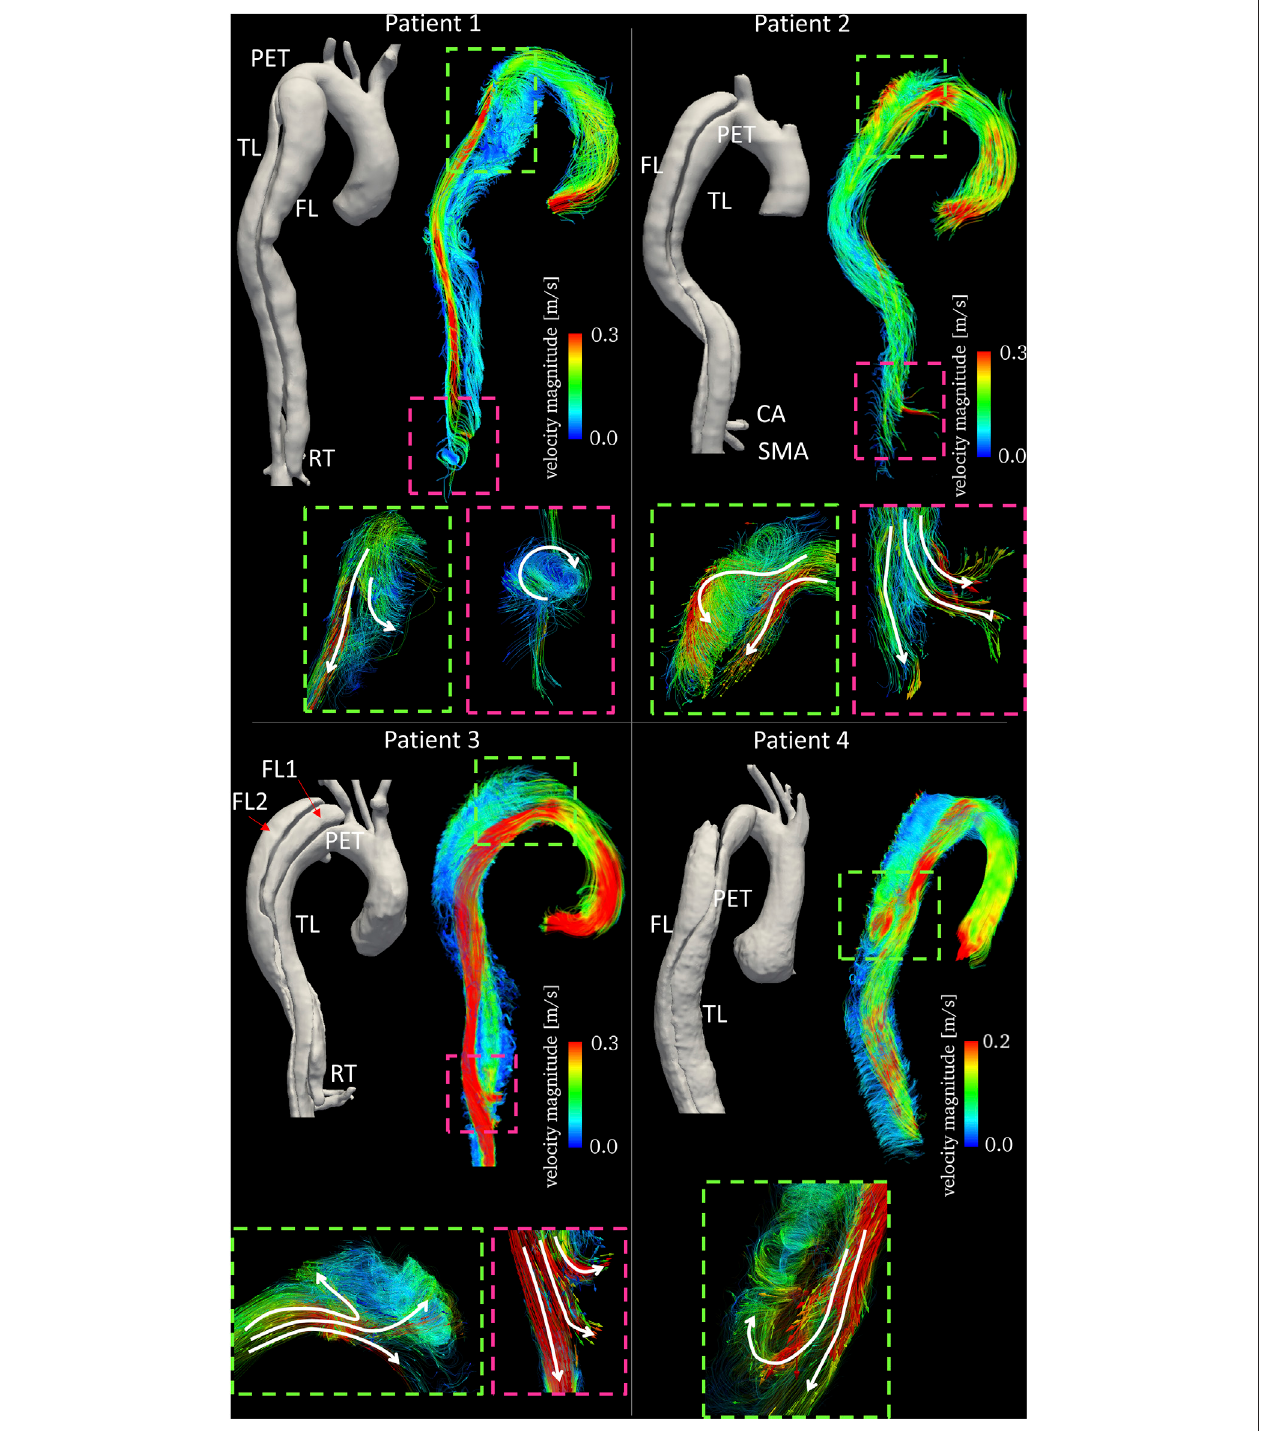
FIGURE 3 | Time averaged velocity streamlines color-coded by velocity magnitude together with 3D aortic reconstructions for the four patients. Text labels indicatingprimaryentrytears(PETs),truelumen(TL),falselumen(FL),celiacartery(CA)andsuperiormesentericartery(SMA)areinwhite.Enlargedsub fi guresareshown at the primary entry tears (dashed green boxes) and re-entry tears (dashed pink boxes) with arrows to emphasize fl ow directionality.